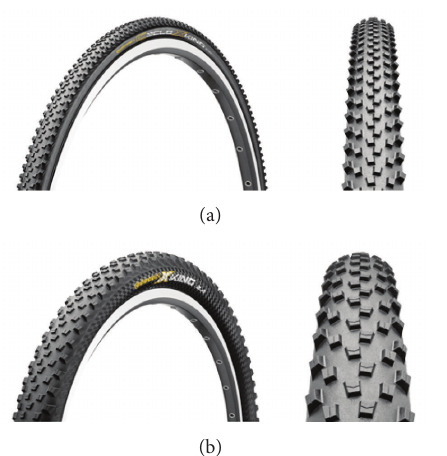
Figure 2: Pictorial image of the two main tyres ((a) cyclocross and (b) mountain bike).